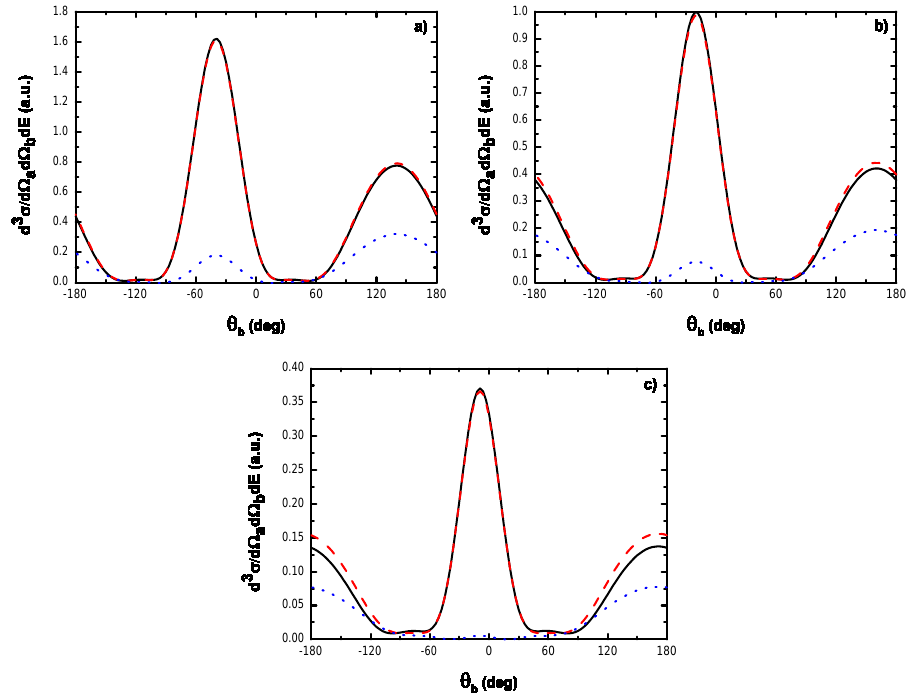
Figure 7. The same as in Figure 5, but the laser polarization vector is parallel to the momentum transfer ( ˆ ε // ∆ )